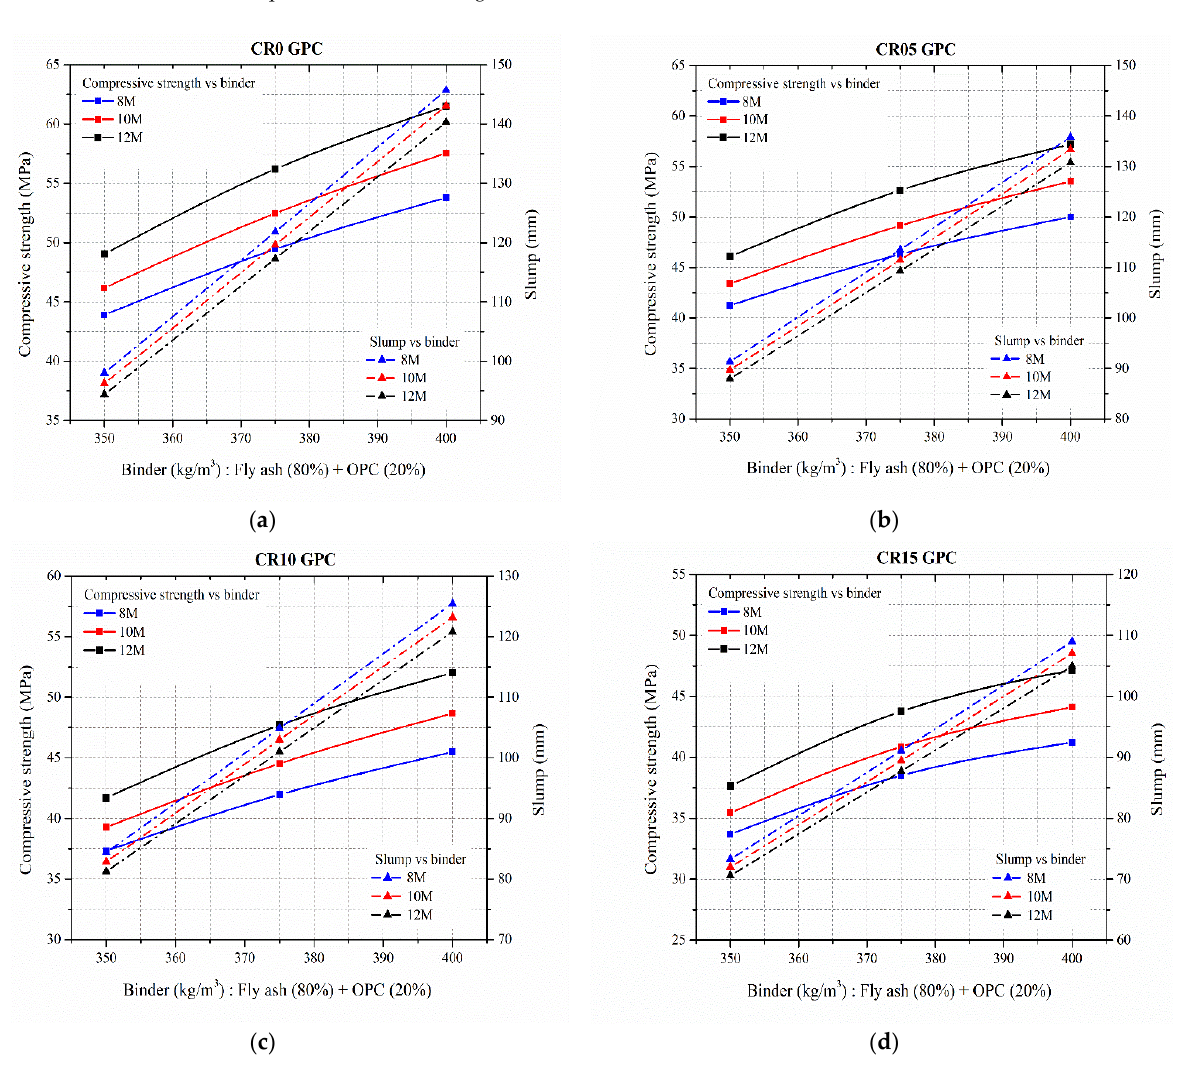
Figure 4. Compressive strength and slump relationships with binder content and molarity at 60 °C curing temperature. Note: CR5-GPC-28D-60: Rubberized Geopolymer Concrete with 5% CR, 28 curing days, and at 60 °C degrees curing temperature.